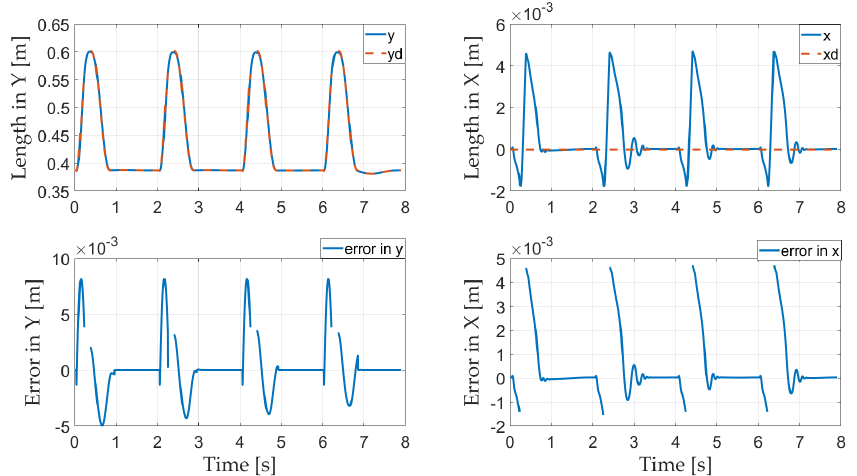
Figure 11. Trajectory of the CoM and its error.